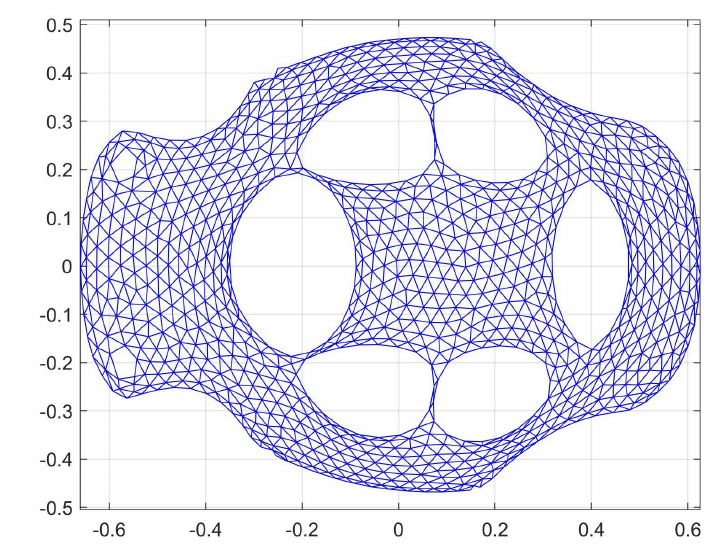
√ √ λ 1 V 1 , λ 2 V 2 ] from the estimated